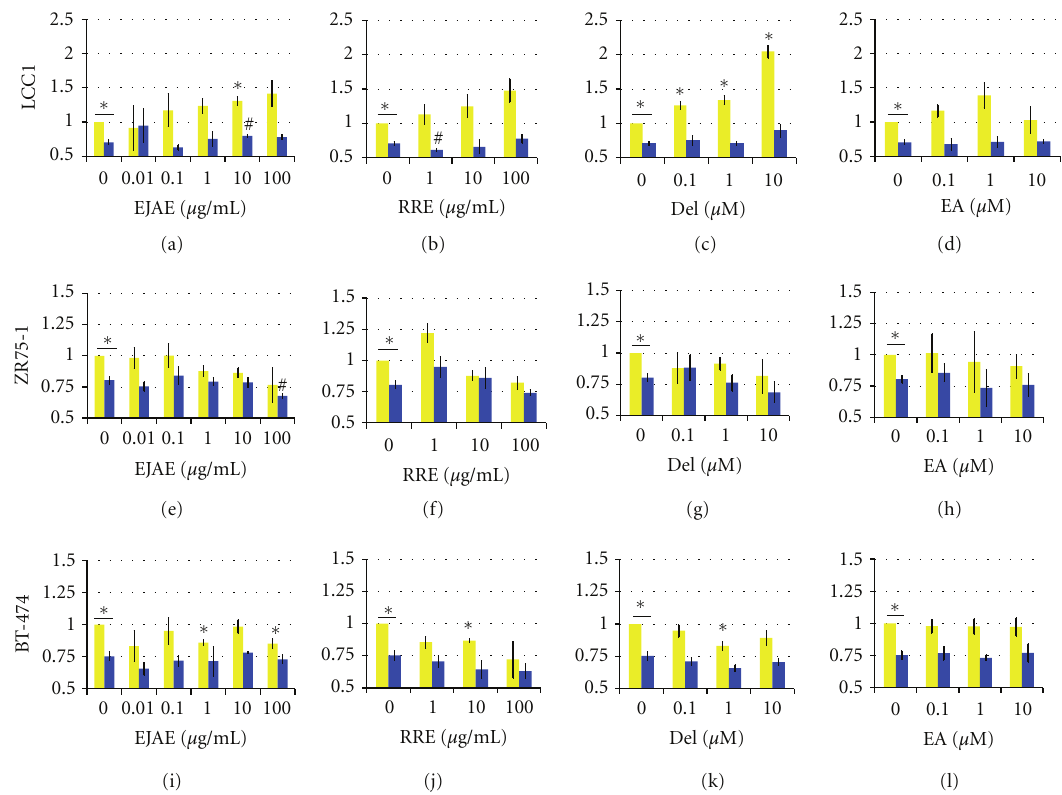
Figure 1: E ff ect of berry extracts and polyphenols on proliferation of ICI-sensitive (LCC1, ZR75-1, BT-474) cell lines. Cell proliferation results from 6d treatment of various cell lines with respective berry extract or polyphenol. Yellow (light) bars represent extract/polyphenol only and blue (dark) bars represent extract/polyphenol +1 nM ICI. Each extract or polyphenol used for treatment was diluted 1000-fold from stock concentration. Vehicle treatment contained 0.01% EtOH and 0.1% DMSO. All treatments were normalized to the appropriate vehicle treatment. Data represented is mean ± standard error of three individual experiments performed in triplicate for each treatment. The means were tested for di ff erence using a t -test and a P ≤ 0 . 05 considered significant. The significantly di ff erent means compared to vehicle control ( ∗ ) or ICI-only treatment ( # ) are